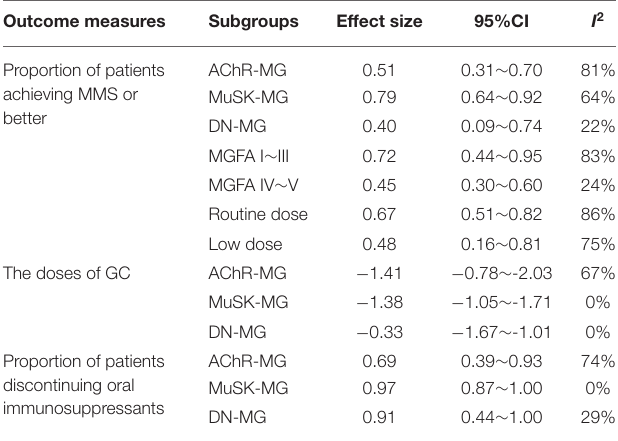
TABLE 2 | Subgroup analysis for outcome measures in patients with